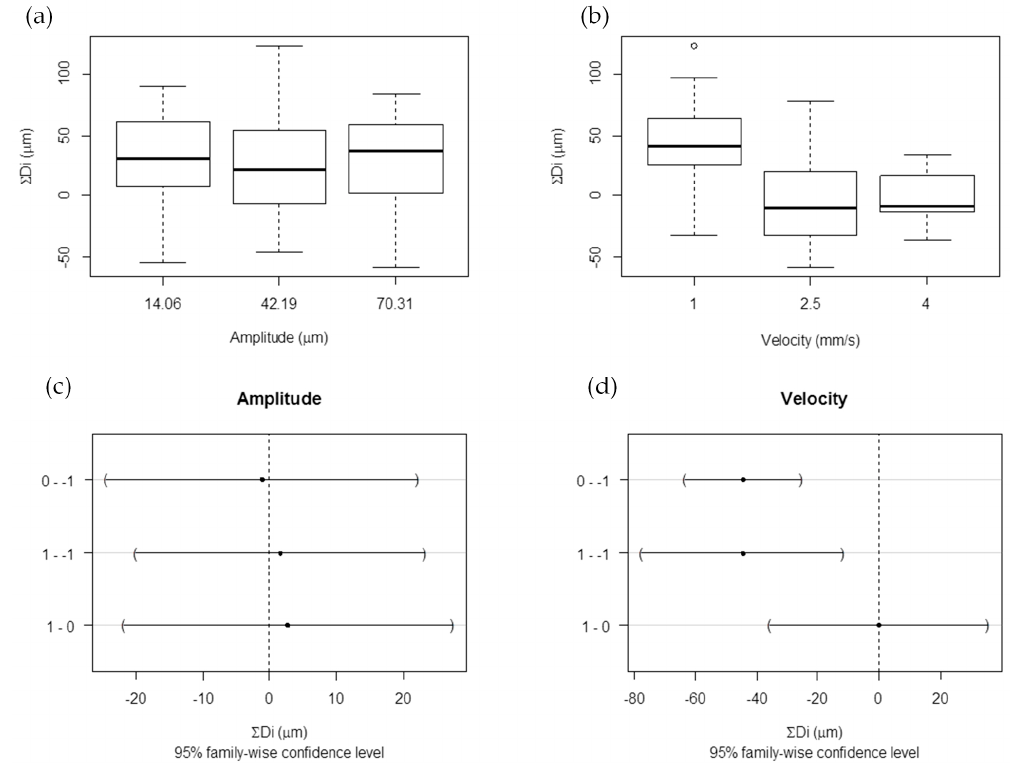
Figure 8. Multiple box plots: ( a ) amplitude and ( b ) velocity and, ANOVA analysis: ( c ) amplitude and ( d ) velocity for first principal component (PC1 = Σ Di).